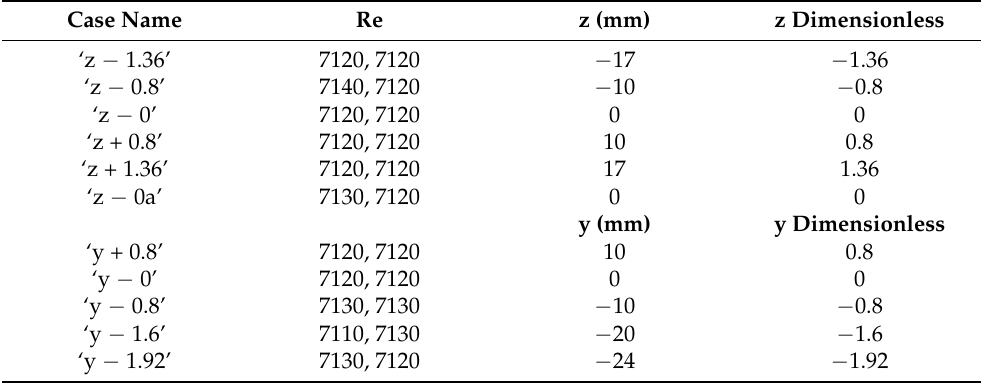
Table 1. List of measurements in the planes z = const. and in the planes y = const. Each case contains two measurements: one with camera at position at x = 4 cm and another at x = 16 cm. Reynolds numbers are given for each of